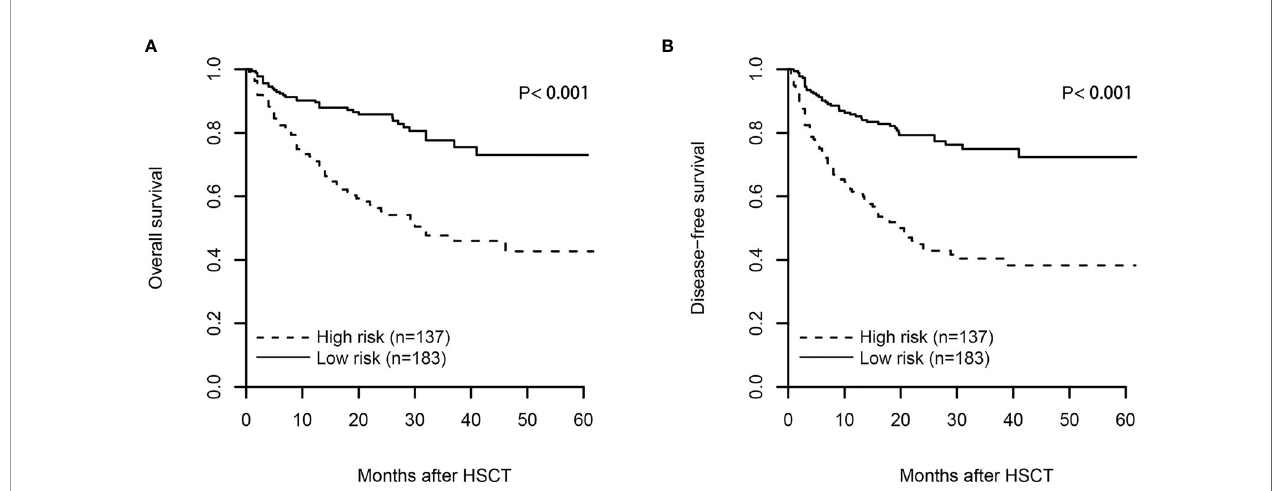
FIGURE 4 | The plot of overall survival (OS, A ) and disease-free survival (DFS, B ) after risk strati fi cation of the nomogram in the training cohort. By using the scoring system from the nomogram, the median cutoff value was adopted to divide the training cohort into two subgroups after ranking by total score (score: from 0 to 9.73 and from 9.73 to 30.58). The log-rank test was used to examine the difference between groups.